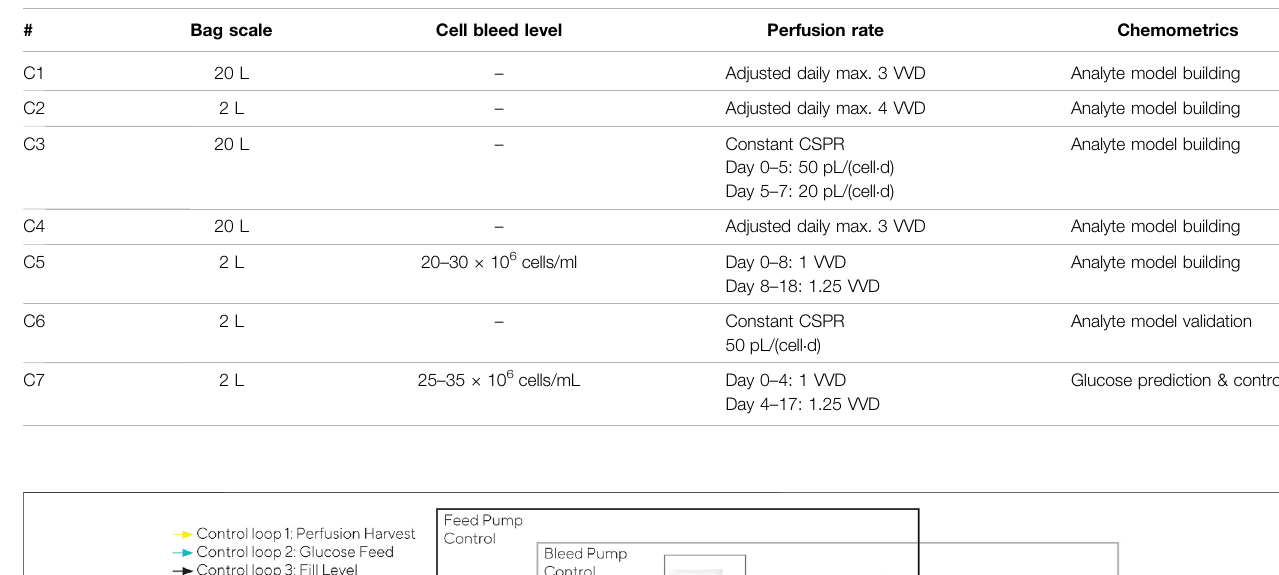
TABLE 1 | Overview of perfusion cultivations.